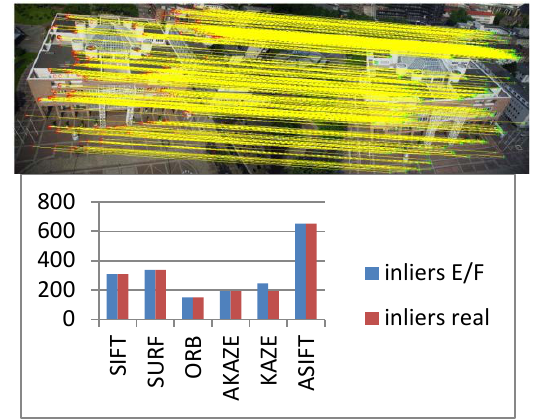
inliers E/F inliers